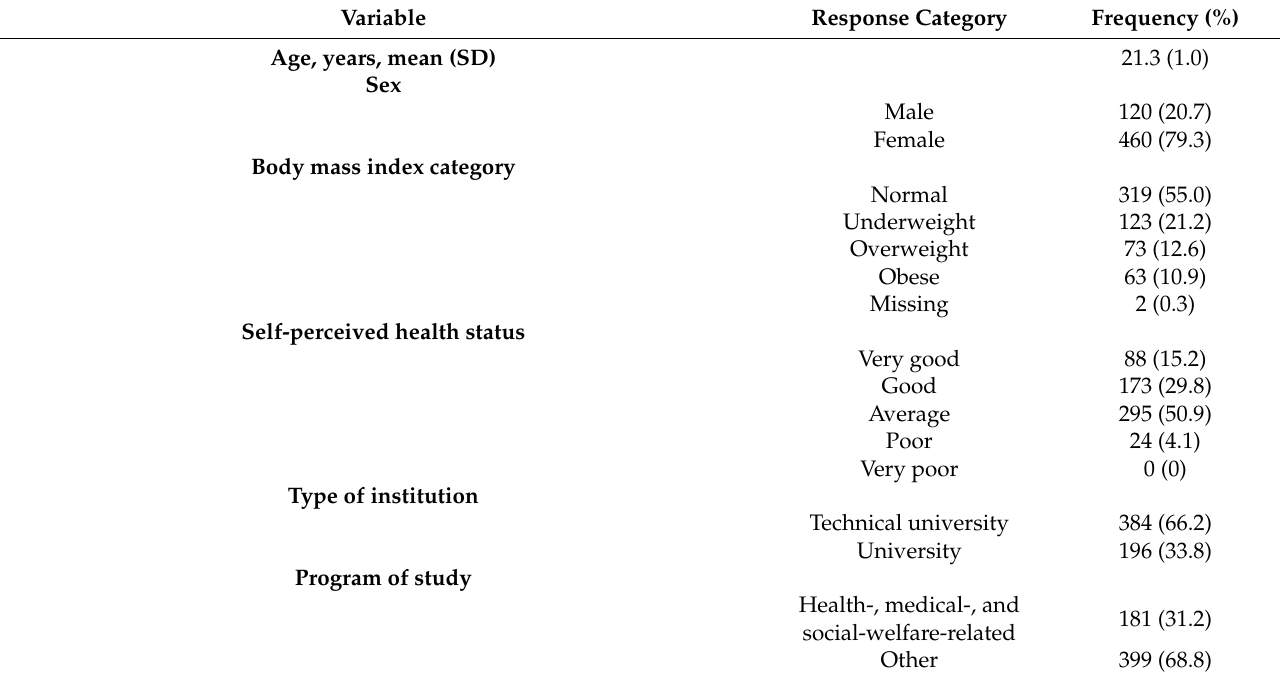
Table 1. Characteristics of the respondents (N =